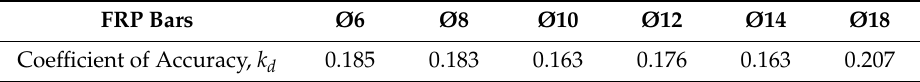
Table 7. Coe ffi cient of accuracy ( k d ) of FRP bars according to diameter.